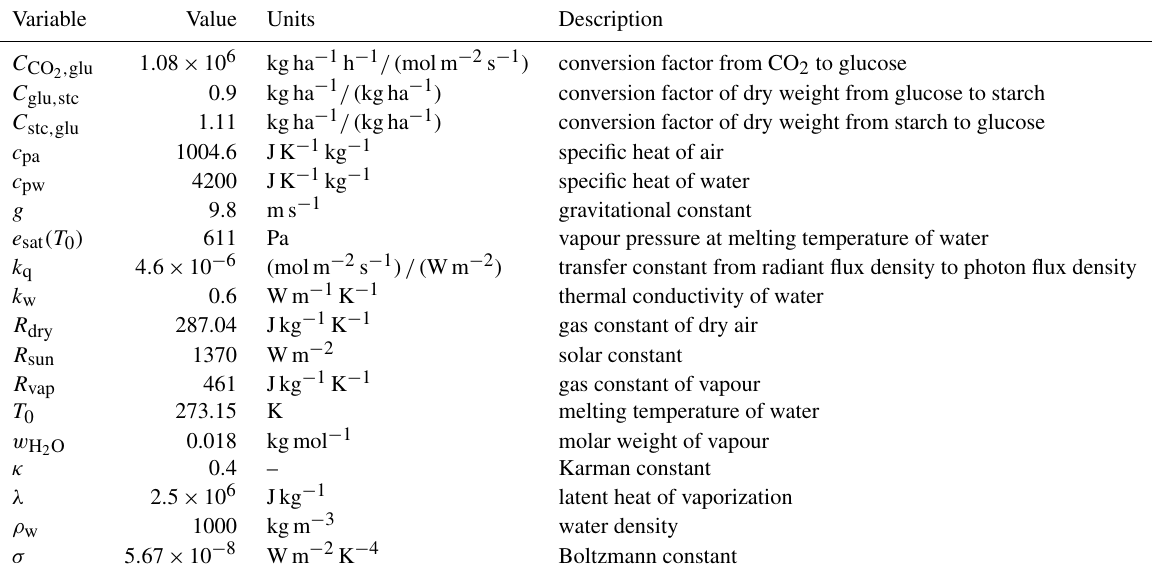
Table 5. Physical and chemical constants.